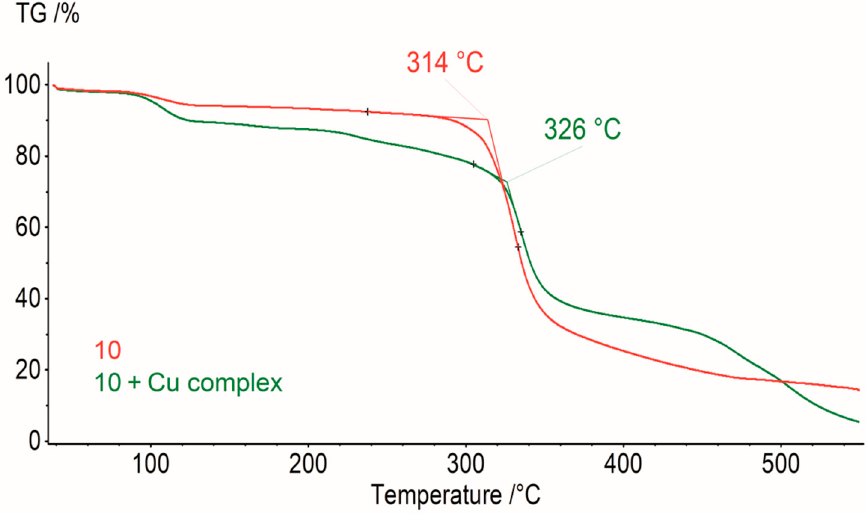
Figure 7. TG curves of compound 10 (red) and 10 + Cu complex (green) in the dynamic argon atmosphere 75 mL/min in the temperature range from 40 to 550 °C.